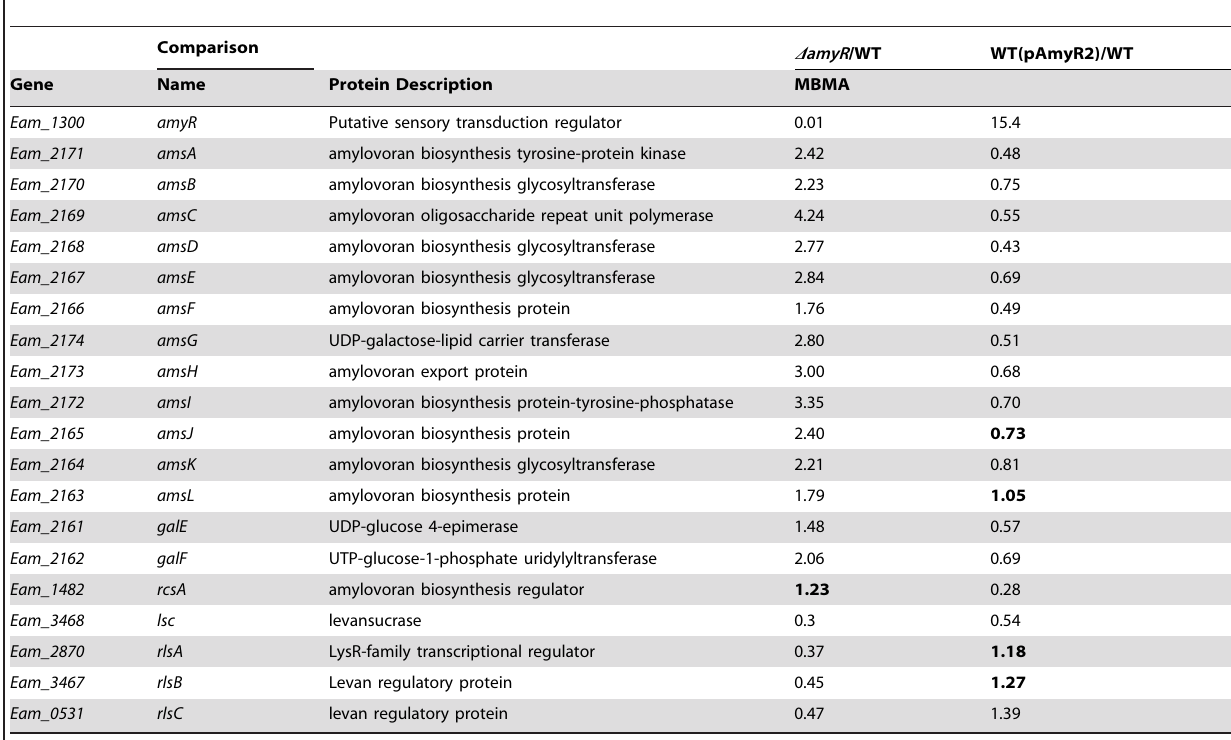
Numbers in bold: p-value . 0.05; all others with p-value , 0.05. Expression ratio $ 2.0 indicates genes are up-regulated in mutants or overexpression strain and # 0.5 indicates genes are down-regulated in mutants or overexpression